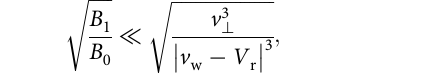
Fig. 3 Phase-space trajectories of typical protons in the plasma rest frame. a Trajectories in the d ζ /d t - ζ phase space. b Trajectories in the v k - v ? plane, in which the velocities are normalized by the Alfvén velocity V A = 290 km s − 1 (computed based on the averaged plasma density N i = 11 cm − 3 and magnetic fi eld strength B = 43.5 nT). c Trajectories in the Energy- ζ phase space. d Trajectories in the v 0 cyclotron resonant velocity, V rp = 55 km s − 1 , is delineated by the dashed line. The circles indicate the proton phase-space locations when they reach the virtual spacecraft. The blue, yellow, red, and pink lines represent protons A, B, A ′ and B ′ , respectively. The purple and green crosses represent protons C and D,